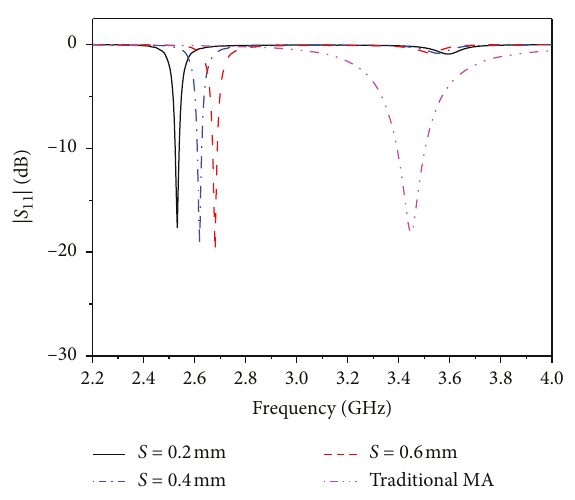
Figure 3: The simulated S 11 varies with S . Table 1: Resonant frequency varied with S.